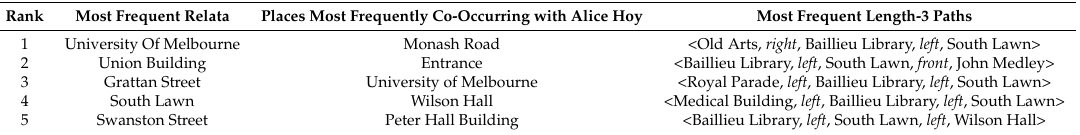
Table 2. Results for the three queries from the third experiment, with the second query using the place Alice Hoy as an